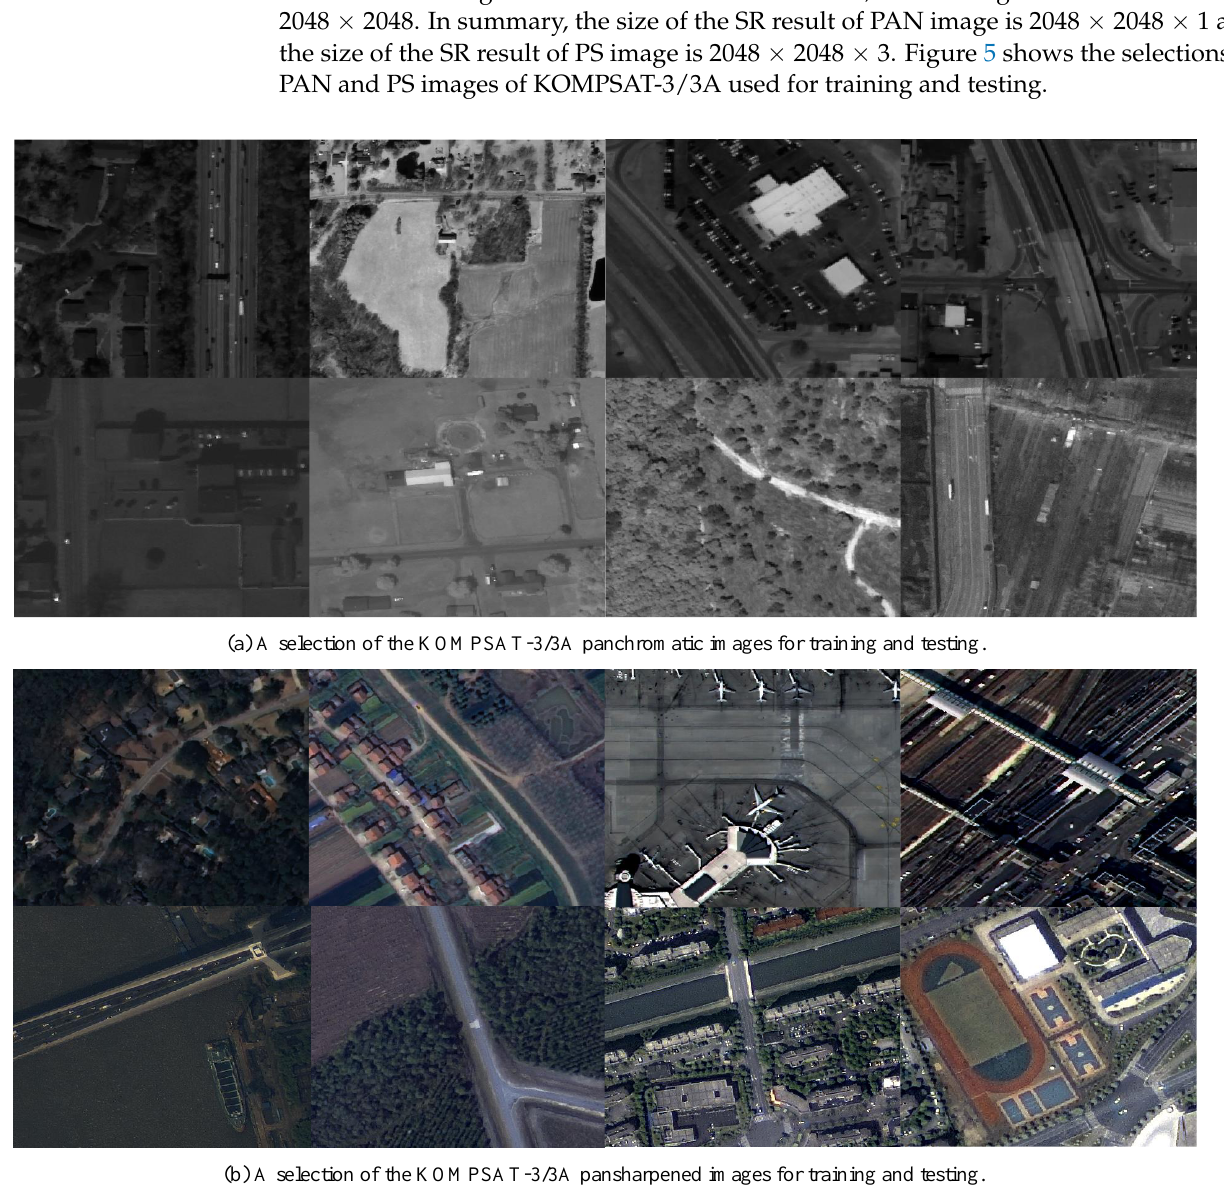
Figure 5. Selected dataset of PAN and PS images of